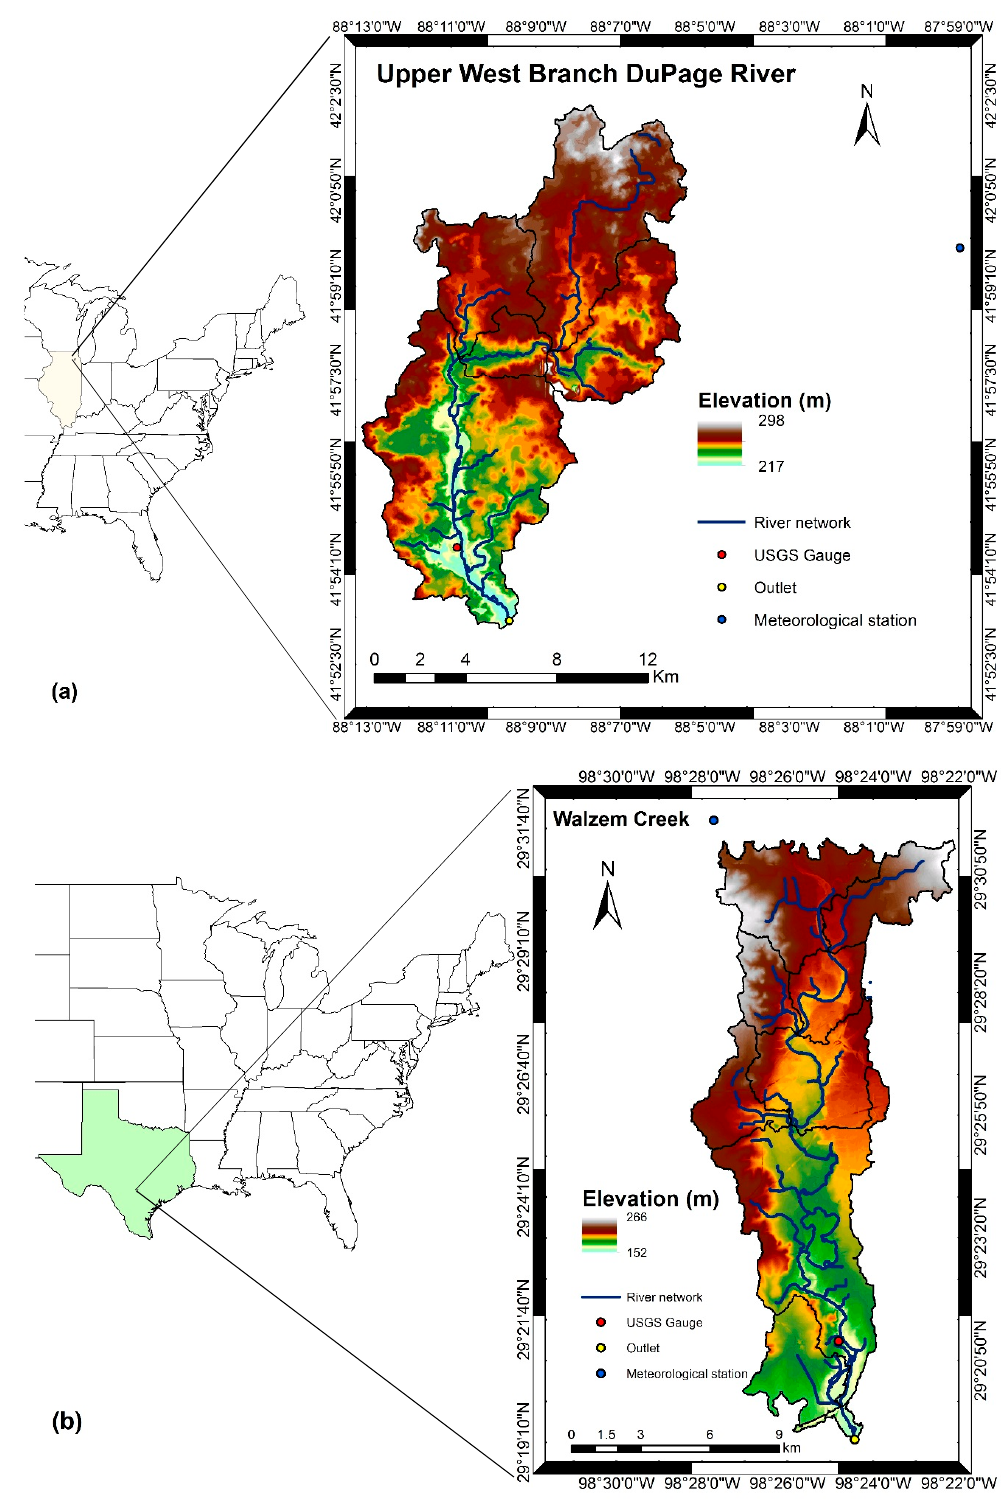
Figure 1. Index map showing location of the study watersheds: ( a ) Upper West Branch DuPage River in Illinois; and ( b ) Walzem Creek in Texas.